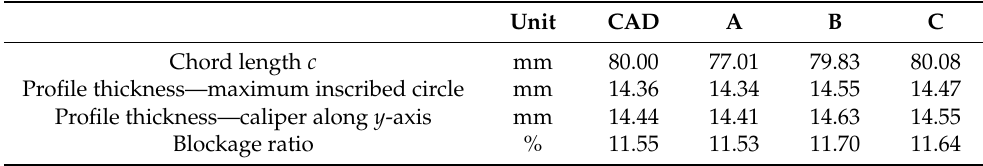
Table 1. Dimensions of the studied airfoil realizations compared with the ideal case, denoted CAD in the first column. The blockage ratio of the wind tunnel is the ratio of the blocked projection area to the total cross-section area (125 × 125mm); it is calculated with the caliper approach—i.e., the distance of the plane touching the suction side to the second plane touching the pressure side, when their normals are locked to the y